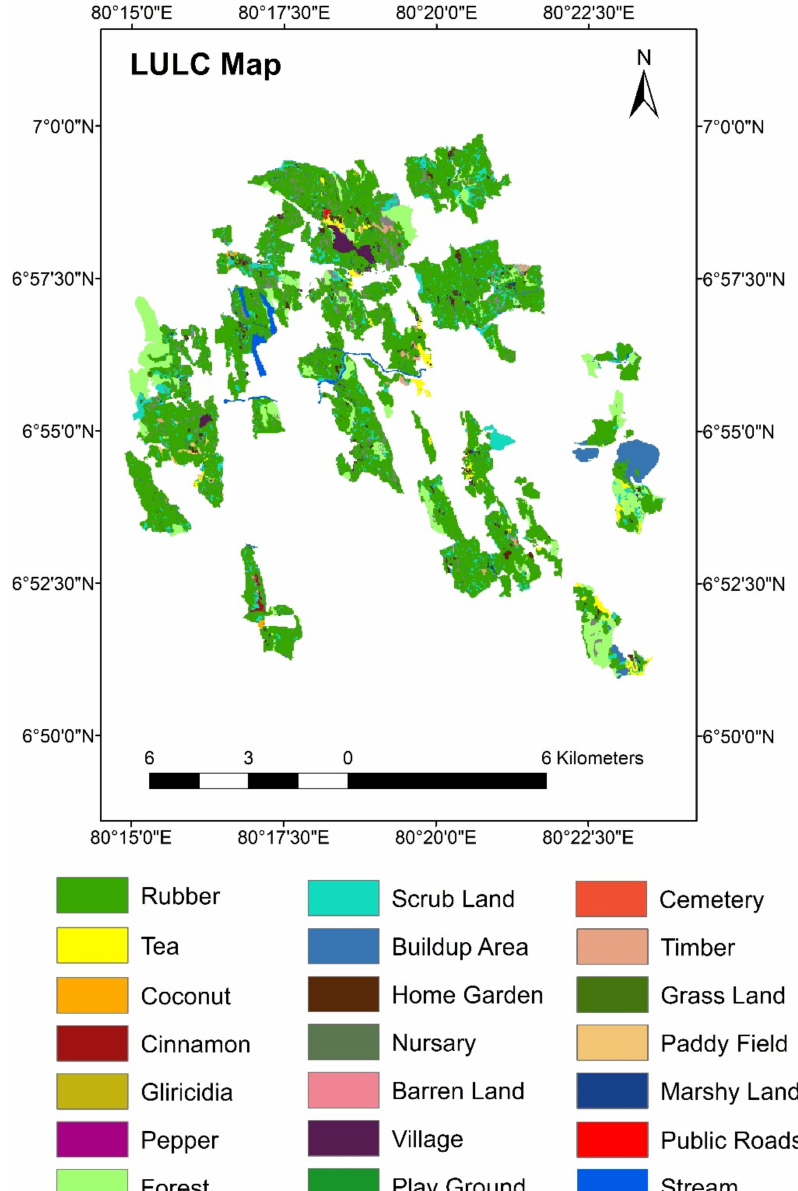
Figure 5. Map of the spatial distribution of LULC types of the study